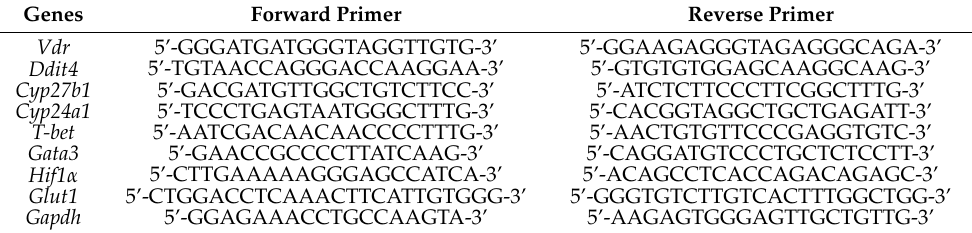
Table 2. Sequences of primers in for quantitative real-time